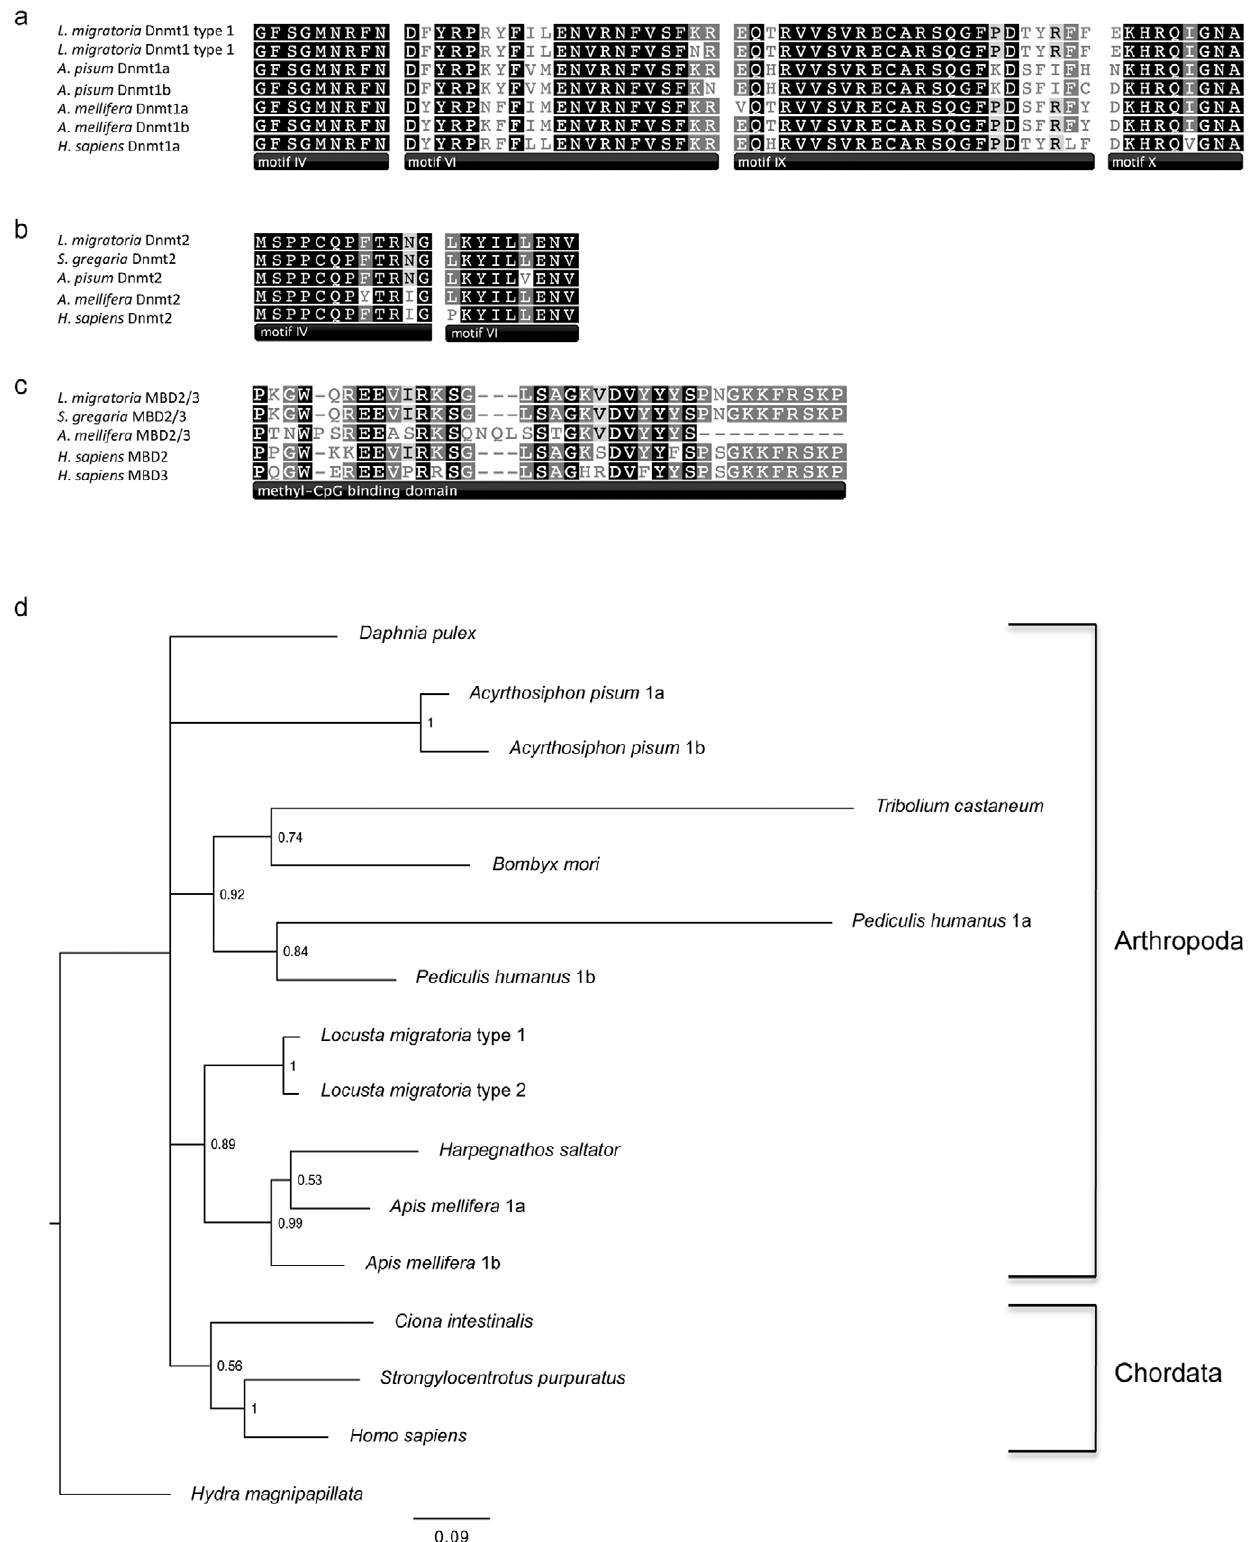
Figure 3. Methylation machinery of L.migratoria . ClustalW alignment of (a) Dnmt1, (b) Dnmt2 and (c) MBD2/3 partial sequences. For clarity, only regions with homology to conserved motifs are presented. Sequences from a larger selection of species were used for phylogenetic analyses, but for simplicity, only a subset of these is shown here. The reported S. gregaria Dnmt1 sequence could not be aligned with the other Dnmt1 sequences presented here. Completely conserved residues are shaded black; 80–99% identical residues are dark grey; 60–79% identical residues are light grey;